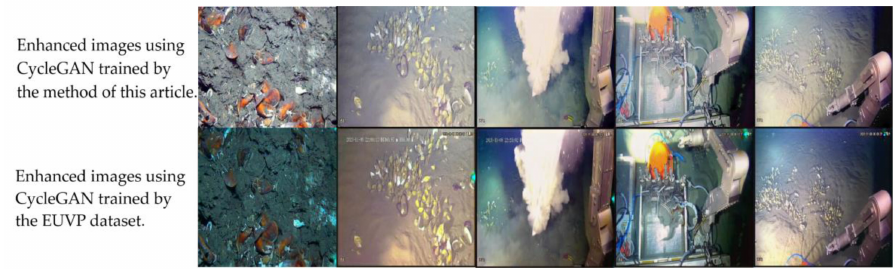
Figure 6. Enhancement results for the trained CycleGAN.